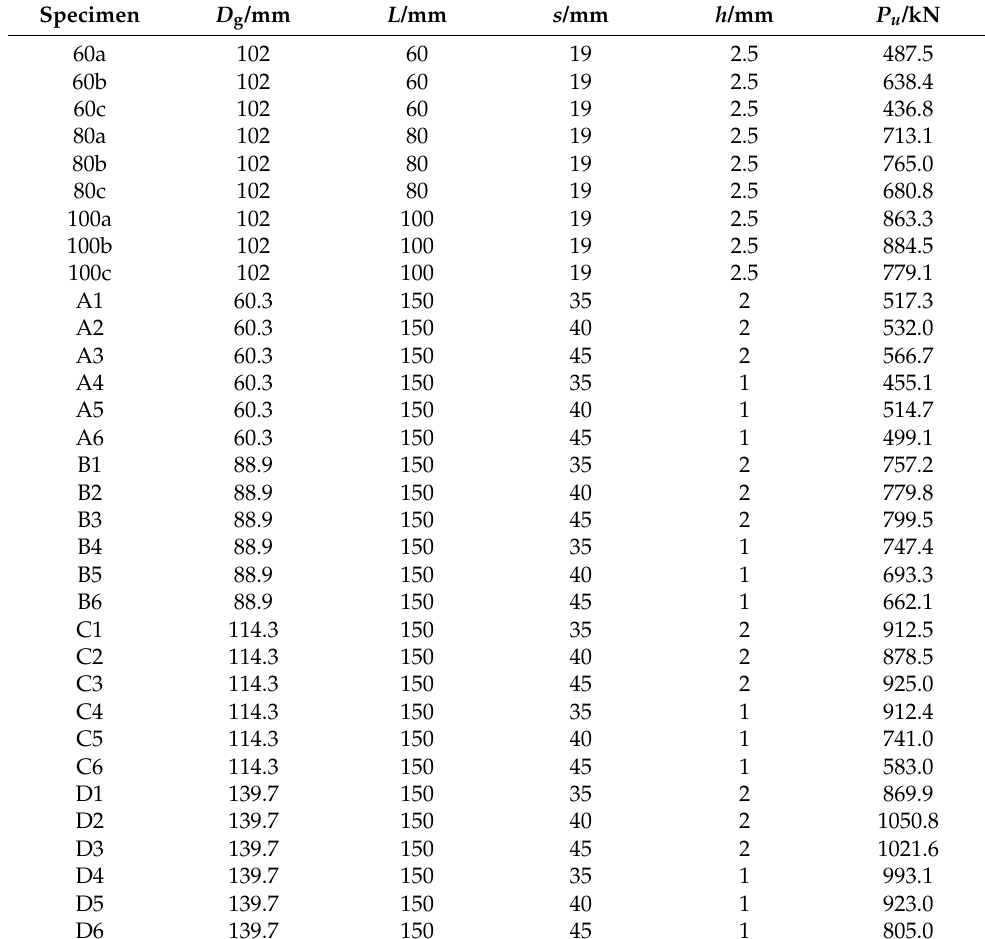
Table 1. Basic information on the specimens.